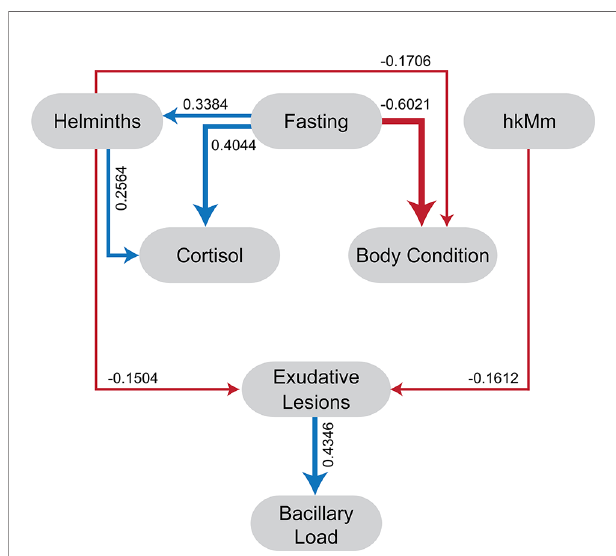
FIGURE 7 | Re fi ned partial least square path model. Red arrows indicate a negative relation among latent variables (path coef fi cient bellow 0) and blue arrows indicate a positive one (path coef fi cient over